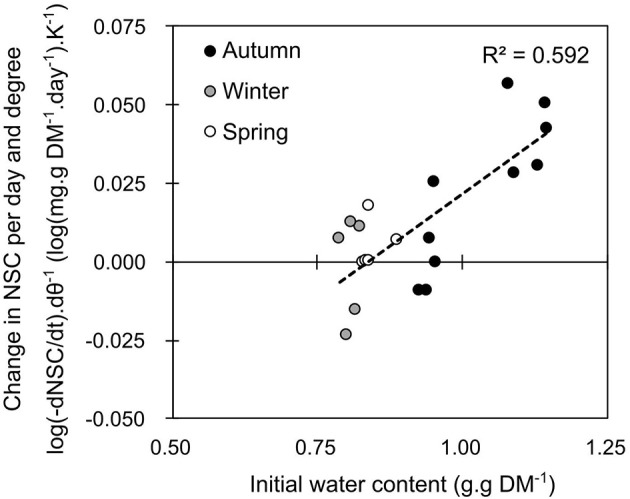
Average daily loss in total non-structural carbohydrates (log(dNSC) per Kelvin) over 7 days of constant temperature treatment depending on initial water content. Each point represents the estimate of the slope from seven branches of an individual tree exposed to seven different temperature from −3 to +25°C.